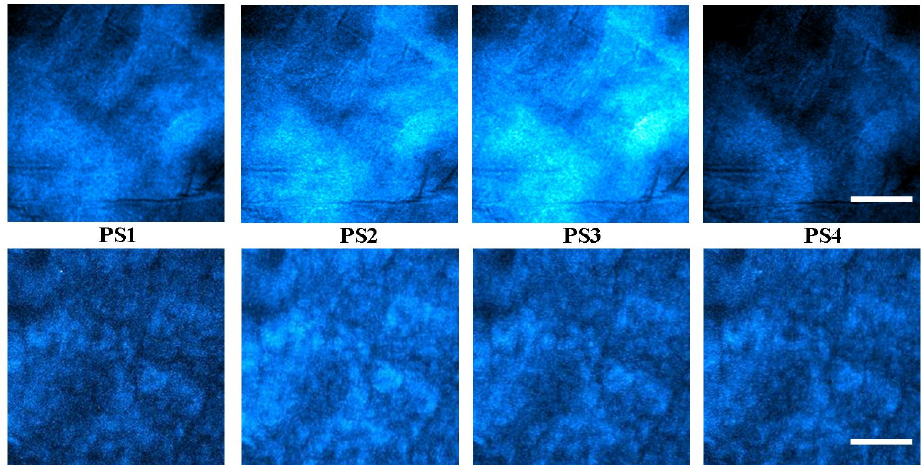
Figure 8. SHG images acquired for 4 independent polarization states (as indicated) for samples with SD = 27° (upper panels) and 40° (bottom panels). Bar length: 50 μm.